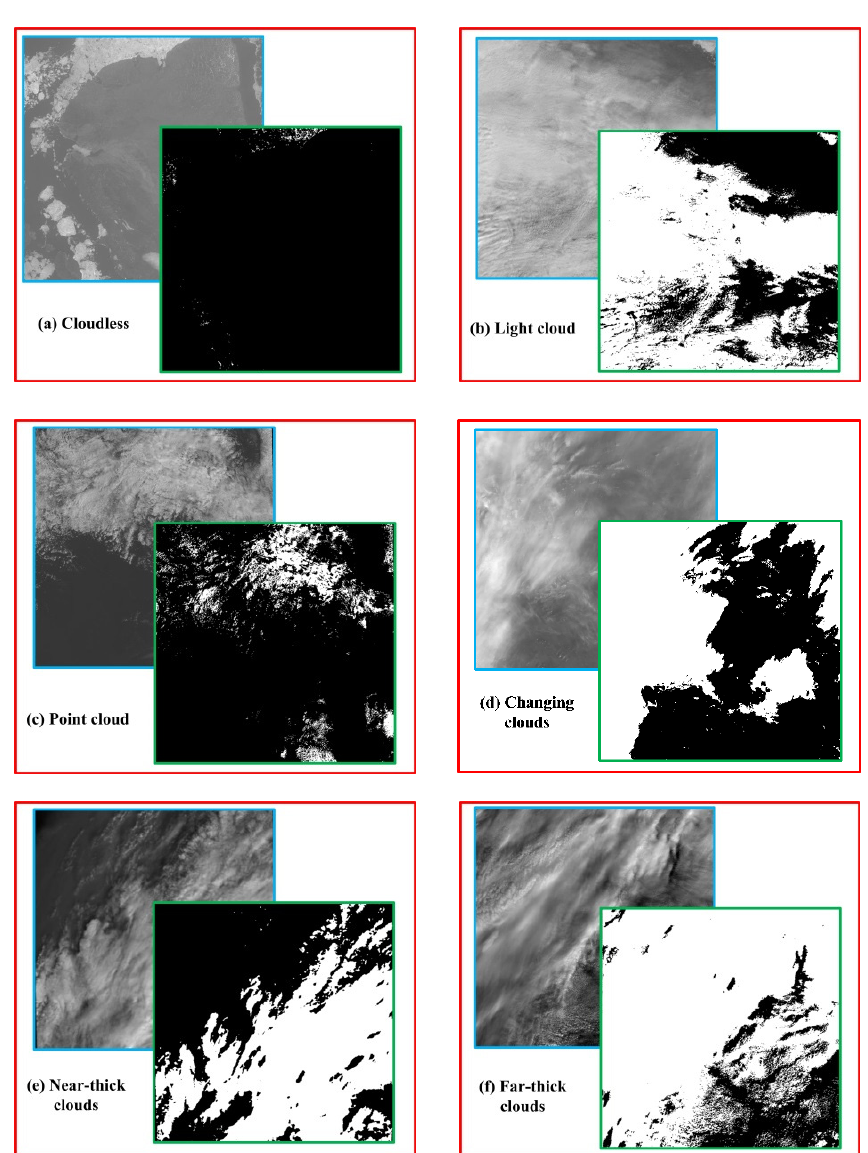
Figure 15. Cloud annotation effect.